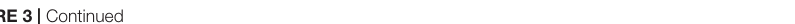
FIGURE 3 | Continued of CD107a staining by CD161 hi CD8 + T cells. Dot plots are gated on CD8 + T cells. (D) Cumulative frequencies (mean ± SEM) of CD107a + CD161 hi CD8 + T cells after stimulation with OKT3 alone or in combination with IFN α 2b. Mann–Whitney test was used to compare frequencies. n = 4, * p < 0.05; ns, not significant. (E) PBMC were either left unstimulated, or stimulated in different conditions: IFN α or OKT3 for 20 h, IFN α for 3 h before adding OKT3 for the next 17 h, or IFN α and OKT3 for 20 h. Brefeldin A was added 4 h after the beginning of the culture. At the end of the incubation period, PBMC were collected and stained for extracellular and intracellular markers as stated in the section “Materials and Methods.” For CD107a expression, the anti-CD107a mAb was incubated with cells during the whole culture period. Figures show cumulative data ( n = 4) for IFN γ production (left panel) and CD107a expression (right panel) by CD161 hi CD8 + T cells under the specified conditions. Statistical comparison was performed with a Friedman test with Dunn’s correction for multiple comparisons. * p < 0.05; ns, not